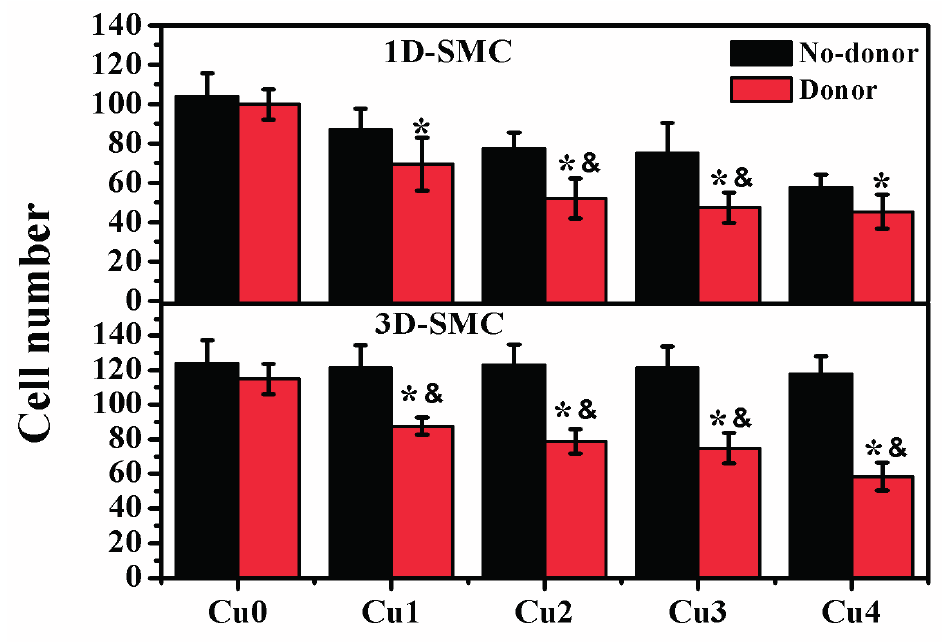
Figure 7. Investigation of SMC number on the Cu0, Cu1, Cu2, Cu3 and Cu4 surfaces via CCK-8 assay after cultures of one day and three days, respectively (mean ± SD, * p < 0.05 compared with Cu0, & p < 0.05 compared with no-donor samples, n =